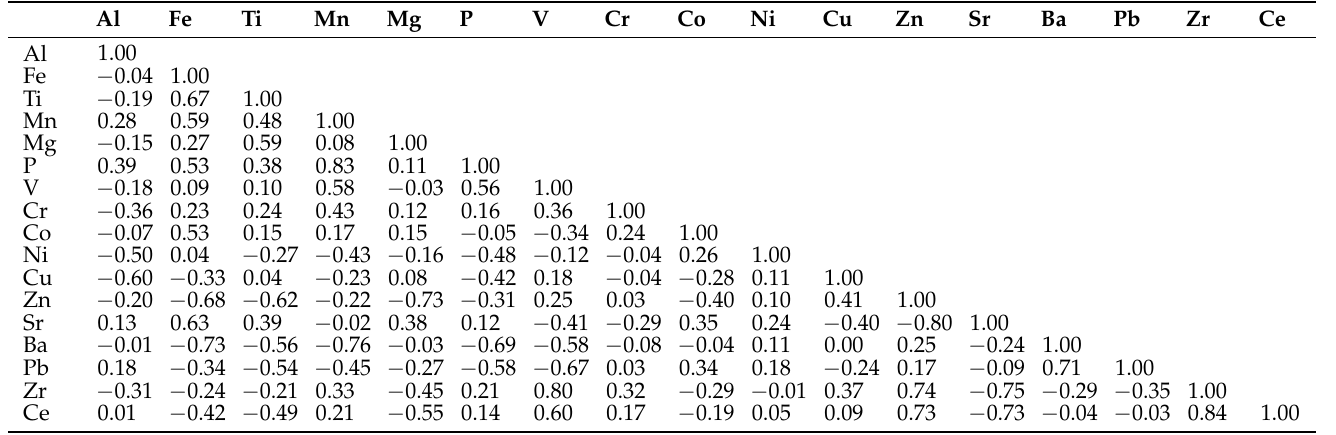
Table 10. Pearson’s correlation matrix of PTEs in surface sediments of littoral shelf.